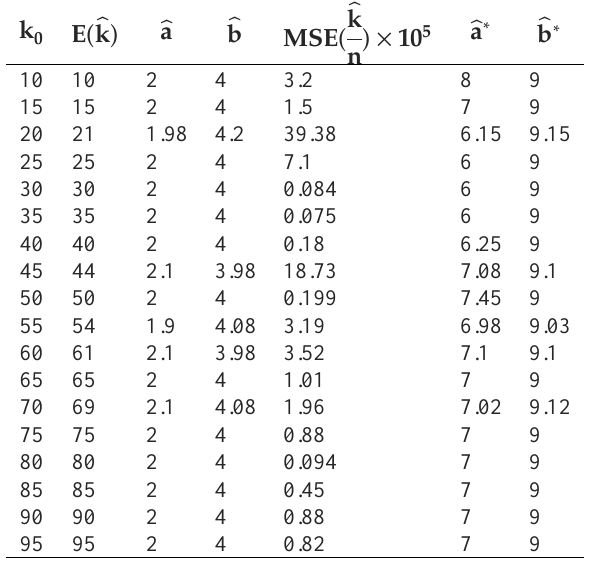
Simulated data: Bayesian approach. Here, the Bayesian result of running the Bayesian change point detection method in the Poisson regression. Table 2. Bayesian results: simulation poisson regression